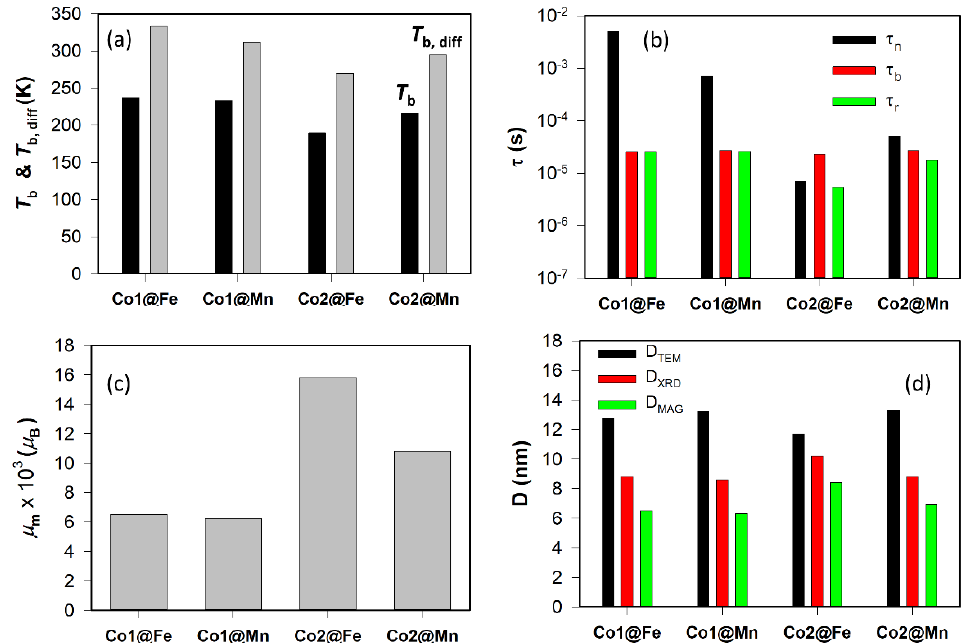
Figure 2. Comparison of the MNPs’ parameters for the Co1@Fe, Co1@Mn, Co2@Fe, and Co2@Mn samples. Mean blocking temperature ( T b ) and blocking temperature at the furcation of the ZFC and FC curves ( T b,diff ) ( a ), N é el ( τ n ), Brownian ( τ b ), and effective ( τ r ) relaxation times ( b ), mean magnetic moment ( μ m ) ( c ), and TEM (D TEM ), XRD (D XRD ) and magnetic (D MAG ) diameters ( d ). The D MAG values are based on the μ m as a statistically relevant parameter (for details about the calculation, please, see Supplementary Materials, section II).